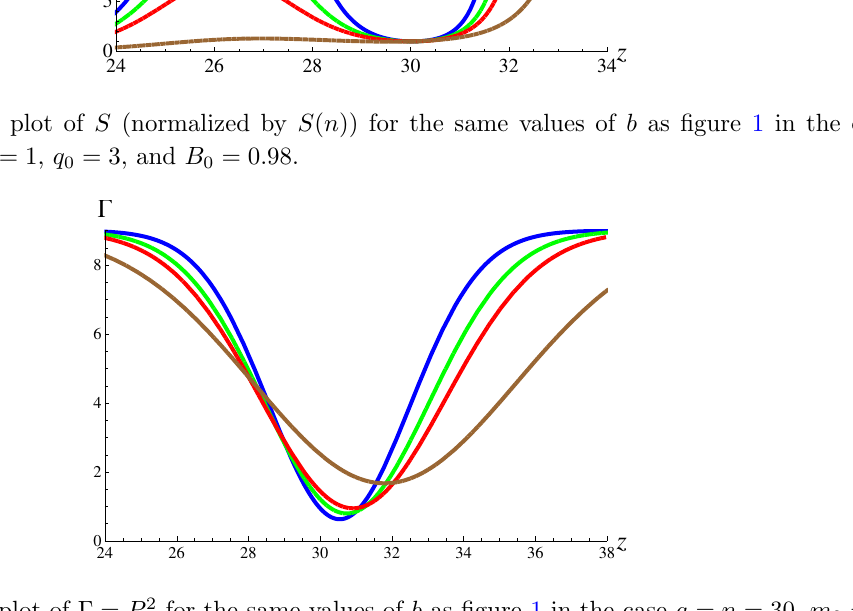
Figure 3 . The plot of (cid:0) = P 2 for the same values of b as (cid:12)gure 1 in the case a = n = 30, m 0 = 1, q 0 = 3, and B 0 = 0 :